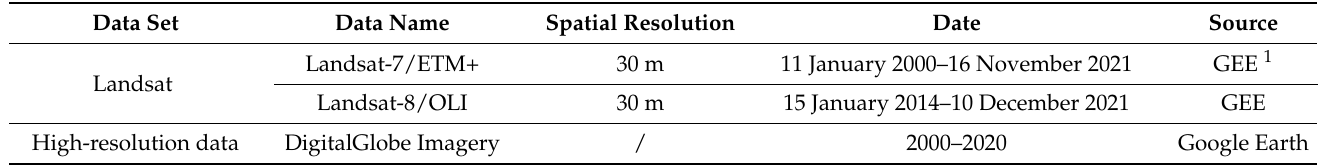
Table 1. The remote sensing data used in this